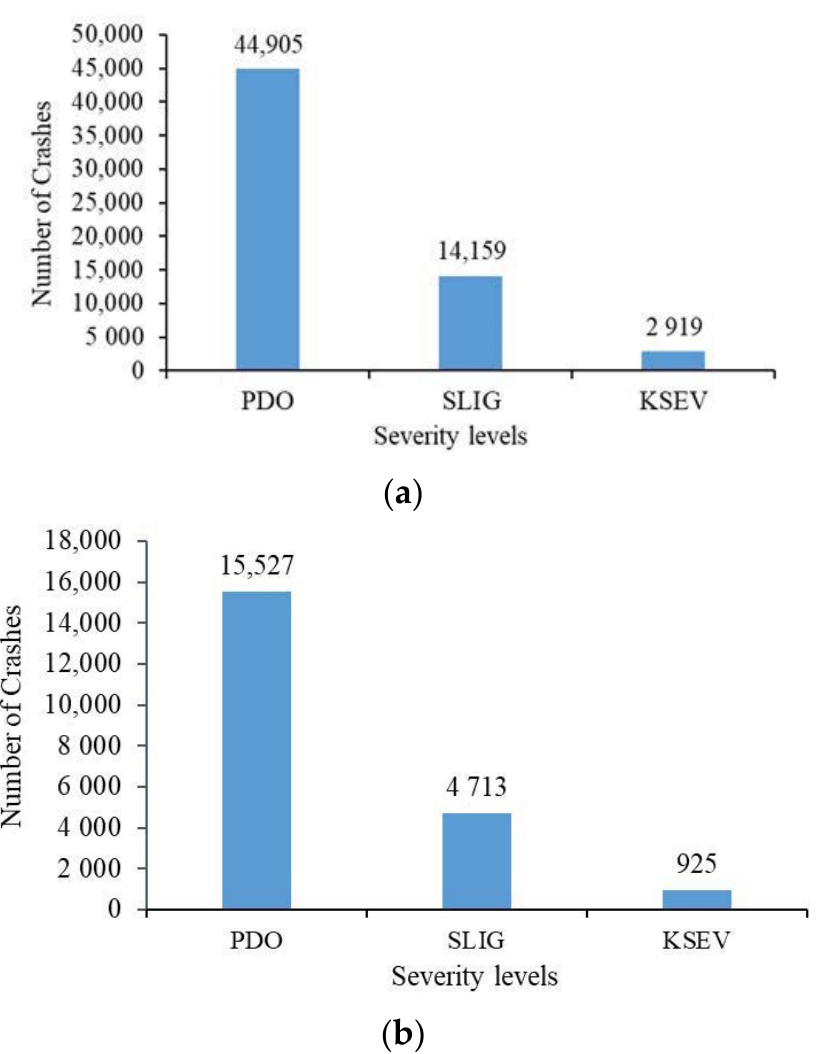
Figure 1. Distribution of Large-Truck Crash Injury Severity in Training and Testing datasets. ( a ) Train- ing dataset. ( b ) Testing dataset.